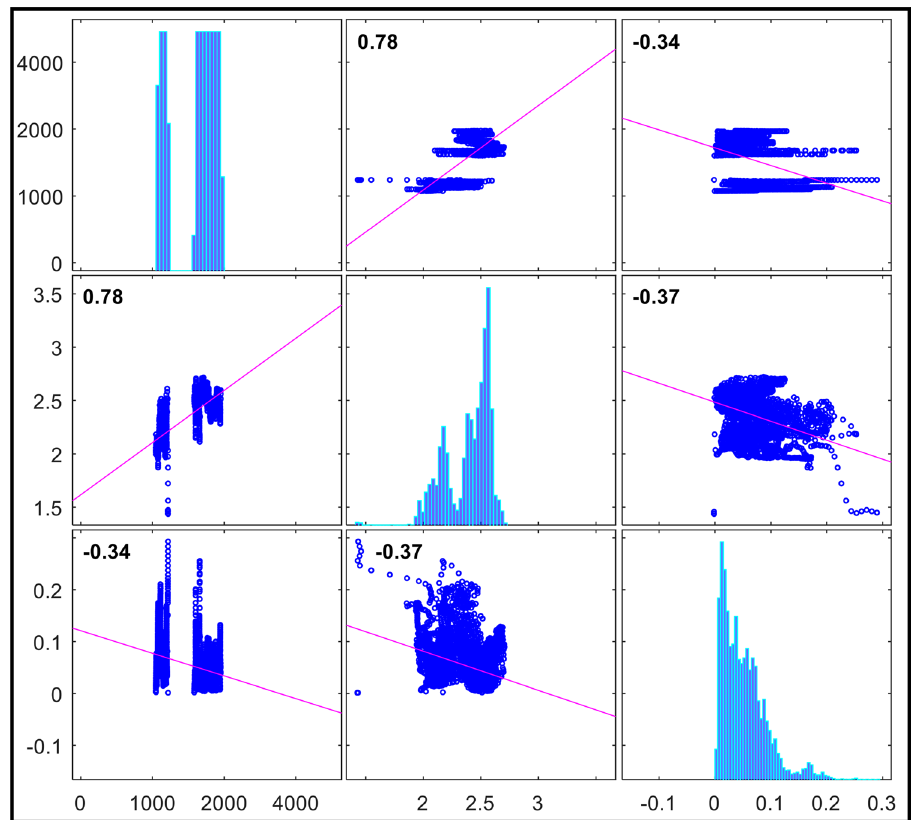
Fig. 10 Well correlation matrix of well-3 among depth, density, and porosity with diagonal histogram and correlation coef- ficient